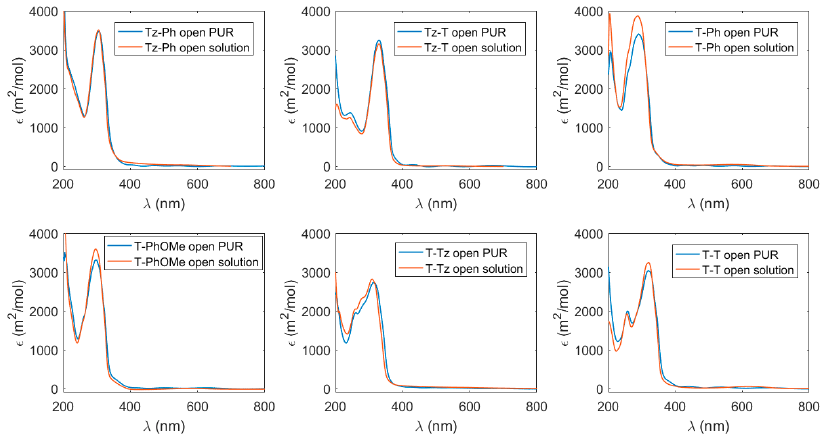
Figure 2. Molar extinction coefficients for the open-ring forms (uncolored) of the investigated monomers dissolved in ethanol (red line) and after polymerization (PU film, blue line).